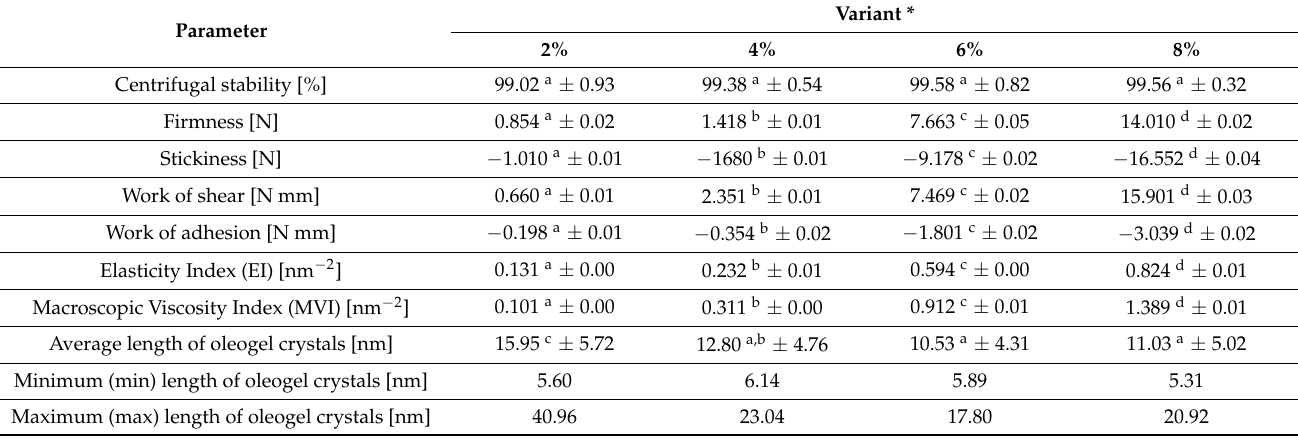
Table 1. Oleogels